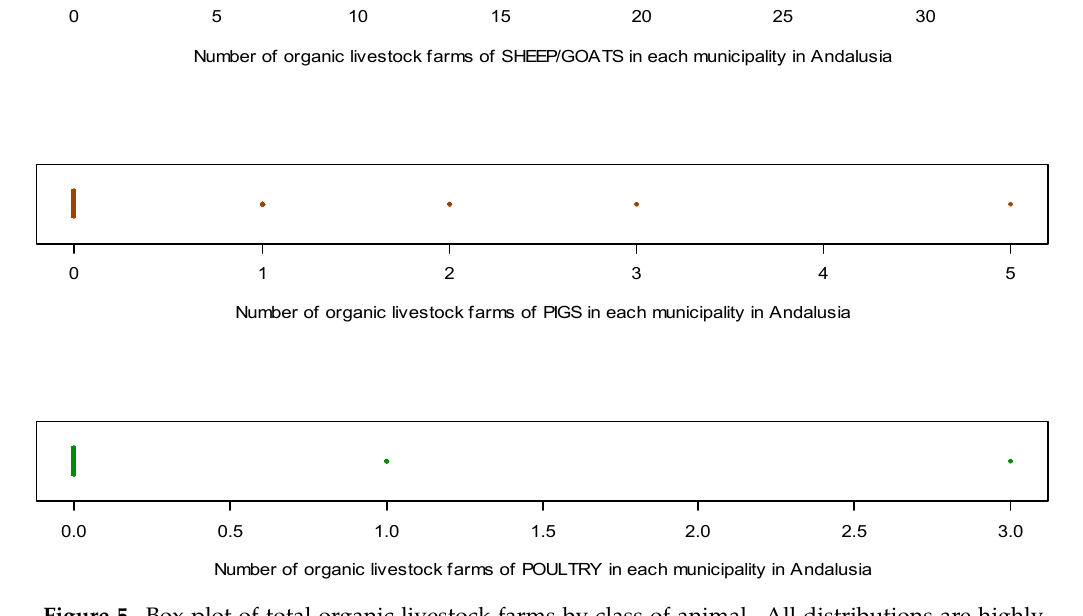
Table 1. Observed frequencies (Freq) for the number of organic livestock farms and estimated frequencies (Fit) by the maximum likelihood estimation (MLE), three moments method (MM3) and moments and frequencies method (MF21).